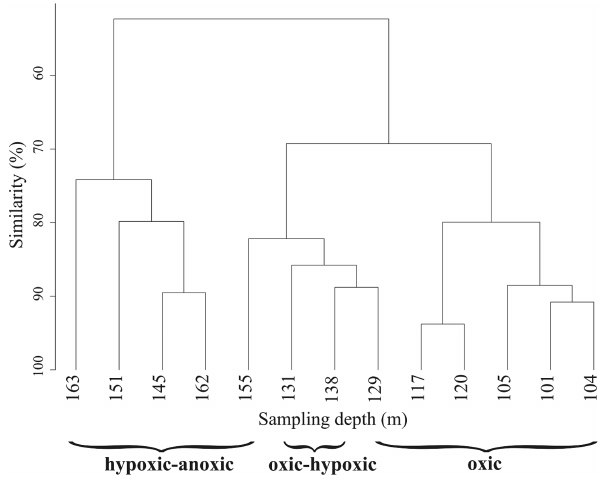
Figure 4. Cluster dendrogram of meiofauna abundances for differ- ent station depths based on the inverse of Bray–Curtis dissimilarity.